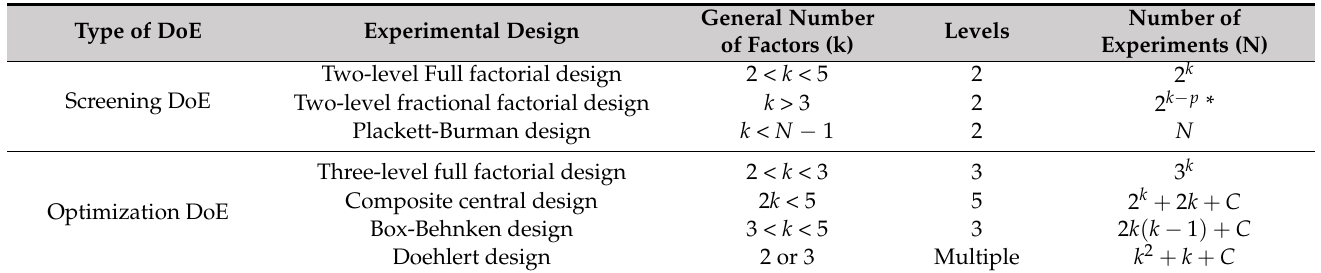
Table 3. Characteristics of screening and optimization DoE.